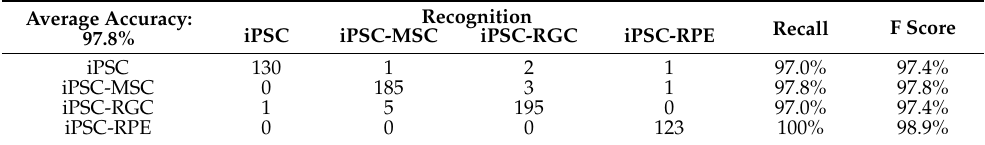
Table 3. Confusion matrix summarizing the recognition results by the multi-slice tensor model.